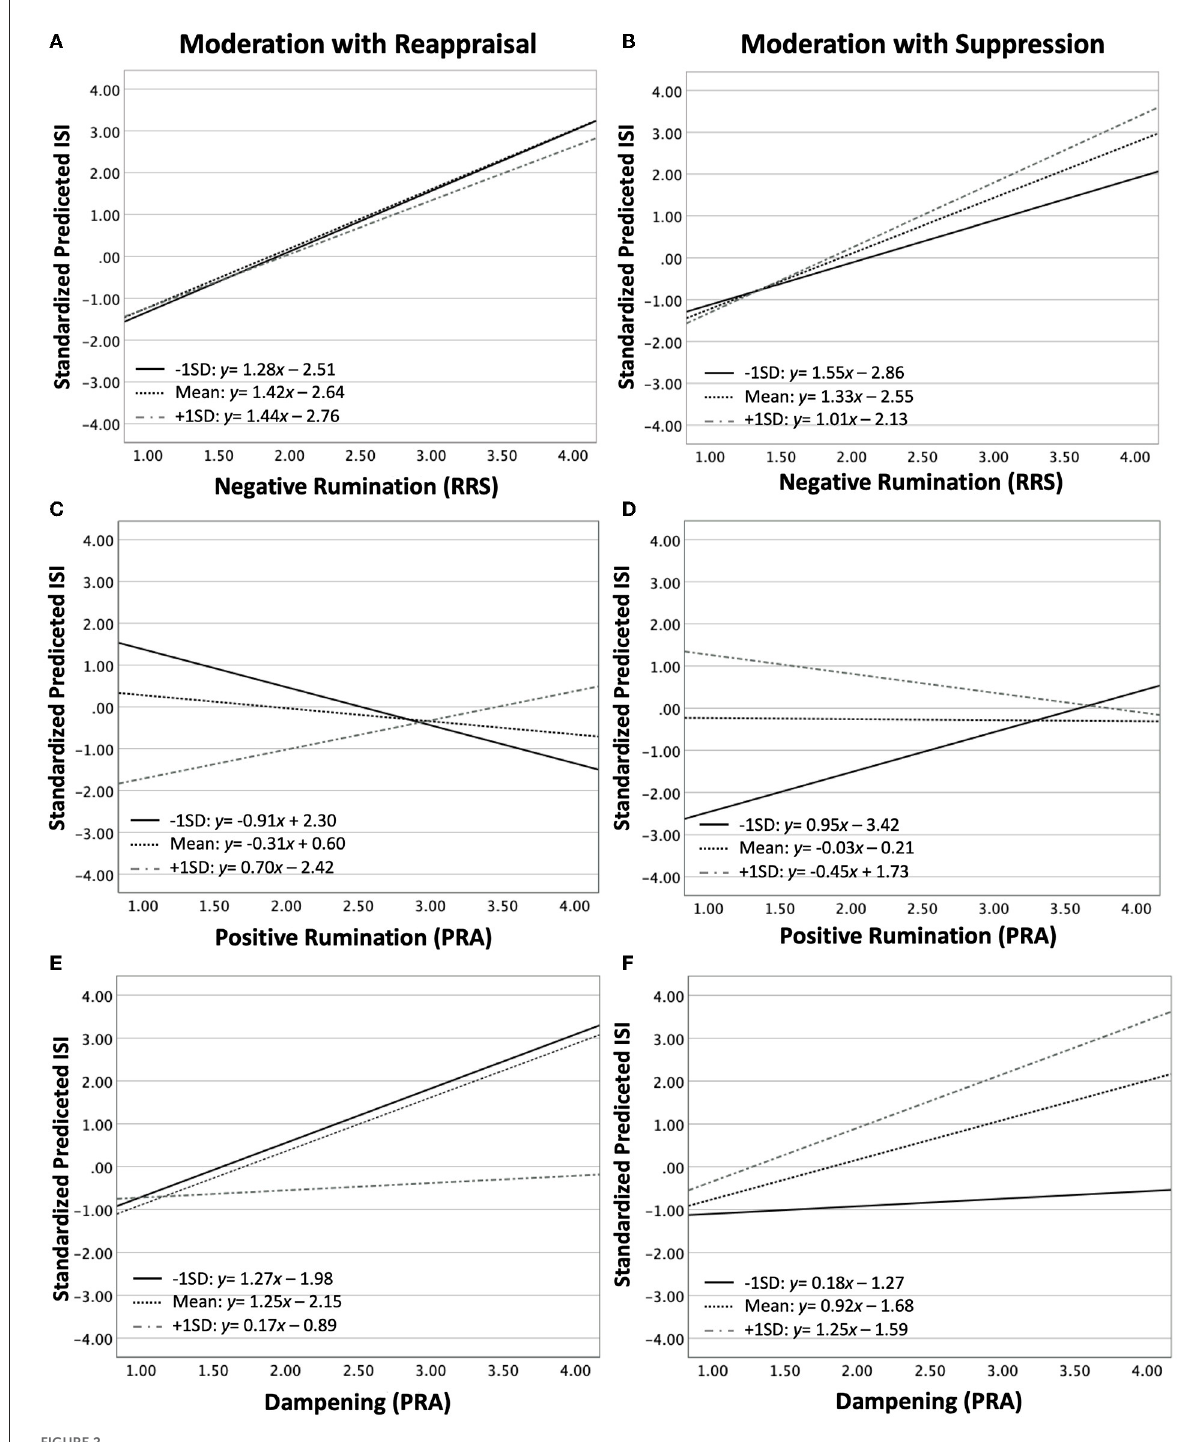
FIGURE2 Testing the moderating effects of Reappraisal (A,C,E) and Suppression (B,D,F) on the association between Negative Rumination (A,B) , Postive Rumination (C,D) and Dampening (E,F) with insomnia Symptoms as reported on the ISI. The ordinate in each graph is the standardized predicted ISI derived from the moderation model for each rumination type. The lines depict the slope and intercept of the association between factors at three levels of the moderator: − 1 standard deviation (SD, full black line), mean (hashed black line), + 1 SD (hashed gray